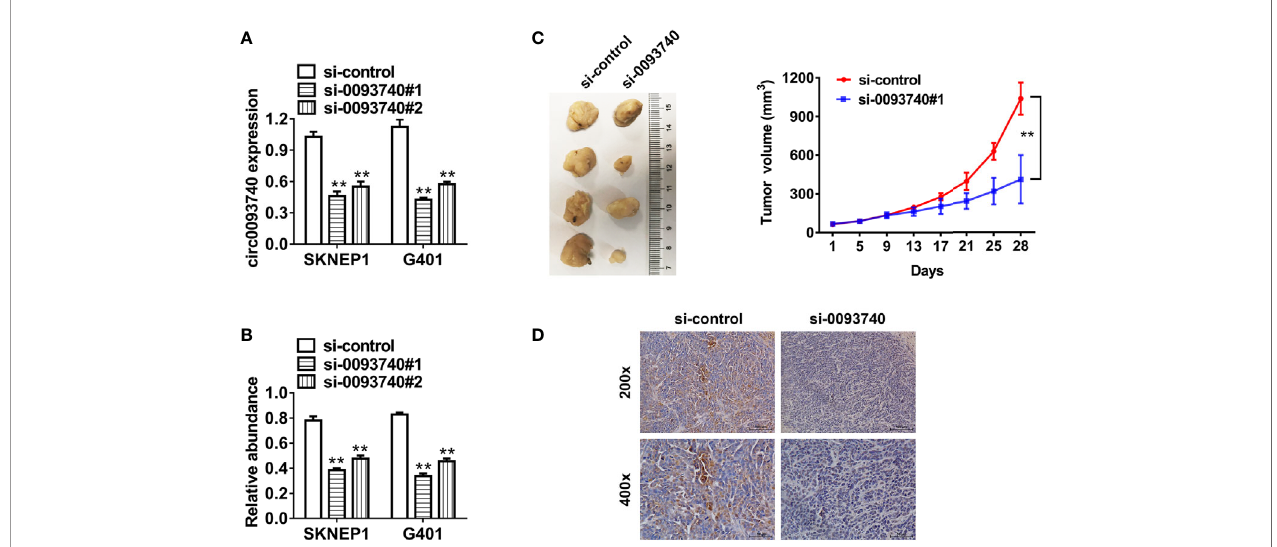
FIGURE 2 | Suppression of circ0093740 inhibits the proliferation of Wilms tumor cells. (A) siRNA knockdown of circ0093740 was validated in SKNEP1 and G401 Wilms tumor cell line. (B) CCK-8 assays were conducted to evaluate cell proliferation in SKNEP1 Wilms tumor cell line. (C) Mouse xenograft models of SKNEP1 Wilms tumor cell line was established. Tumor volume was estimated in every four days. (D) The images of Ki-67 IHC expression are presented. **p <